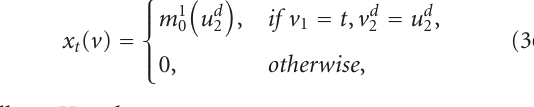
where Δ denotes symmetric di ff erence and Θ δ ± 1 = { τ ± 1 | τ ∈ Θ δ } . Note that irrespective of d we have 1 ∈ Θ 1 . As an example for d = 2 we have Θ 2 = { 2 } , Θ 1 = { 1,3 } and Θ 0 = { 4 }